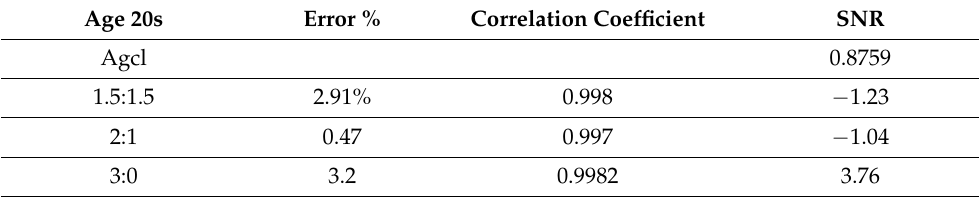
Table 2. Comparison of three different electrode concentrations based on the age group of the 20s.